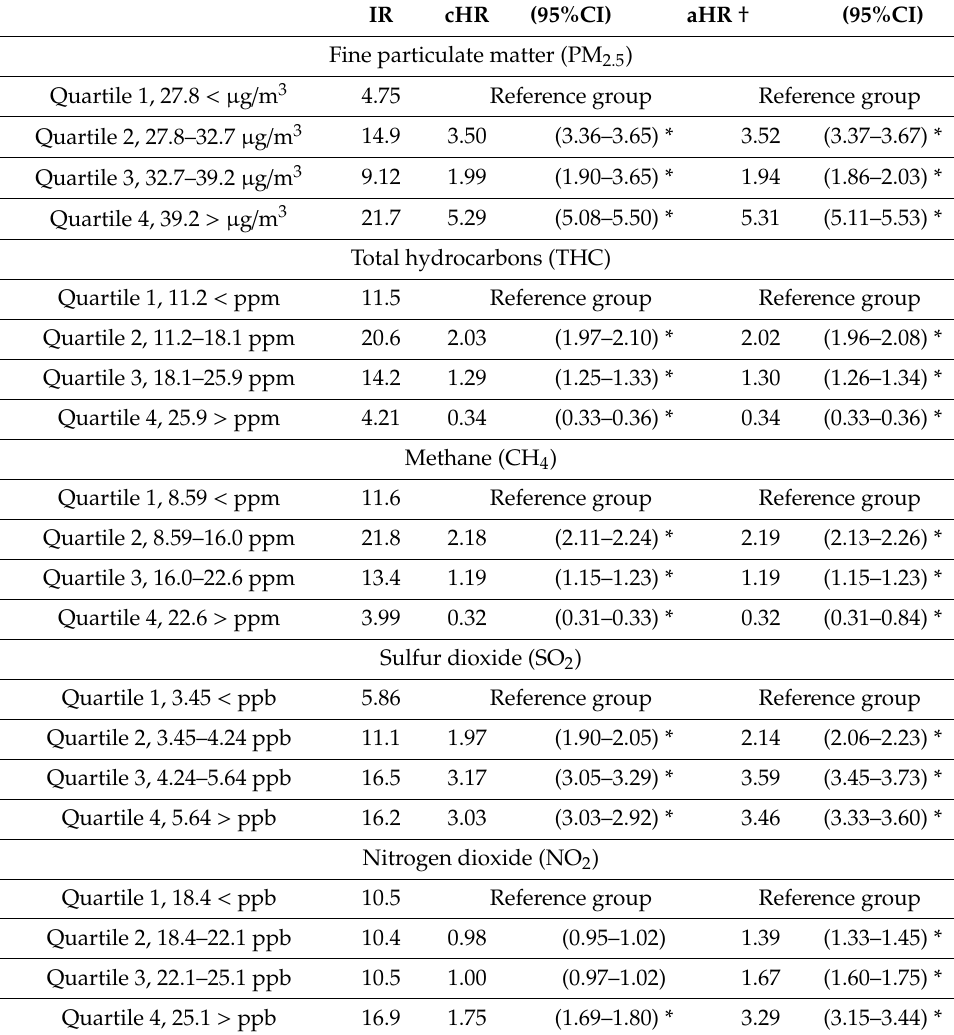
Table A1. The risk of migraine and recurrent headaches in children exposed to air pollutants stratified by quartile of monthly average concentration in Cox proportional hazard regression by spatial scale